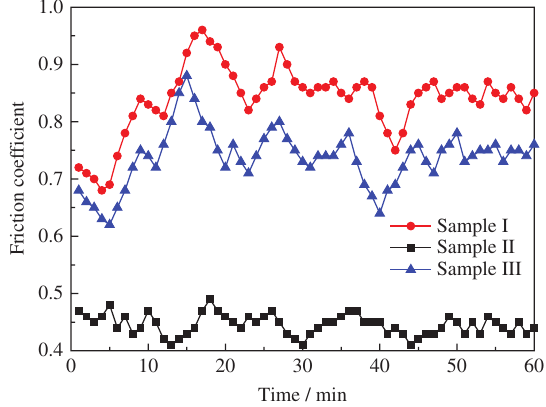
Figure 8: Relationship between the friction coefficient of Ni-TiN composite coatings and wear